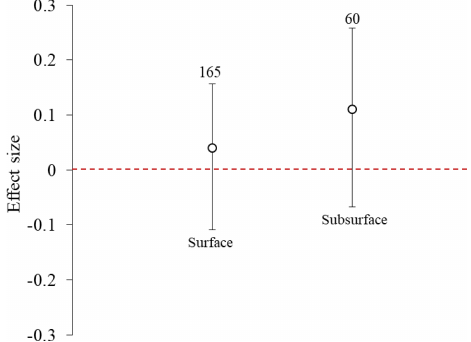
Figure 2. Influence of the soil layer on the effect sizes of the soil saturated hydraulic conductivity under conservation tillage (CS) from a global meta-analysis of 69 studies. The error bars indicate the effect sizes and 95% bootstrap confidence intervals (CIs). The effect of CS was statistically significant if the 95% CI did not bracket zero. The sample size for each variable is shown next to the